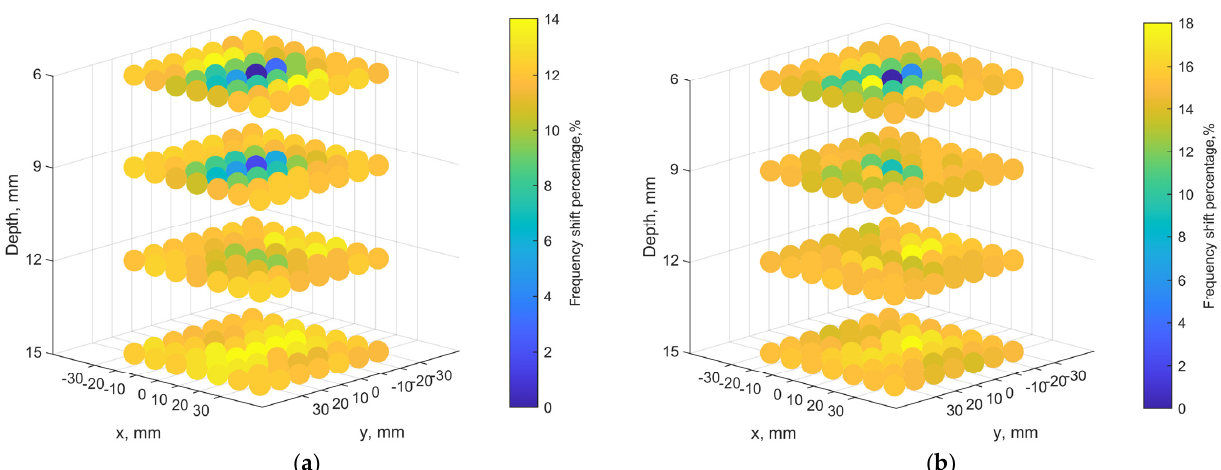
Figure 14. Localization maps with the transmitter loop in different depths of 6, 9, 12, and 15 mm: ( a ) at the orientation where the ports are aligned, and ( b ) at a rotated orientation of port by 90° from the cases in ( a ).